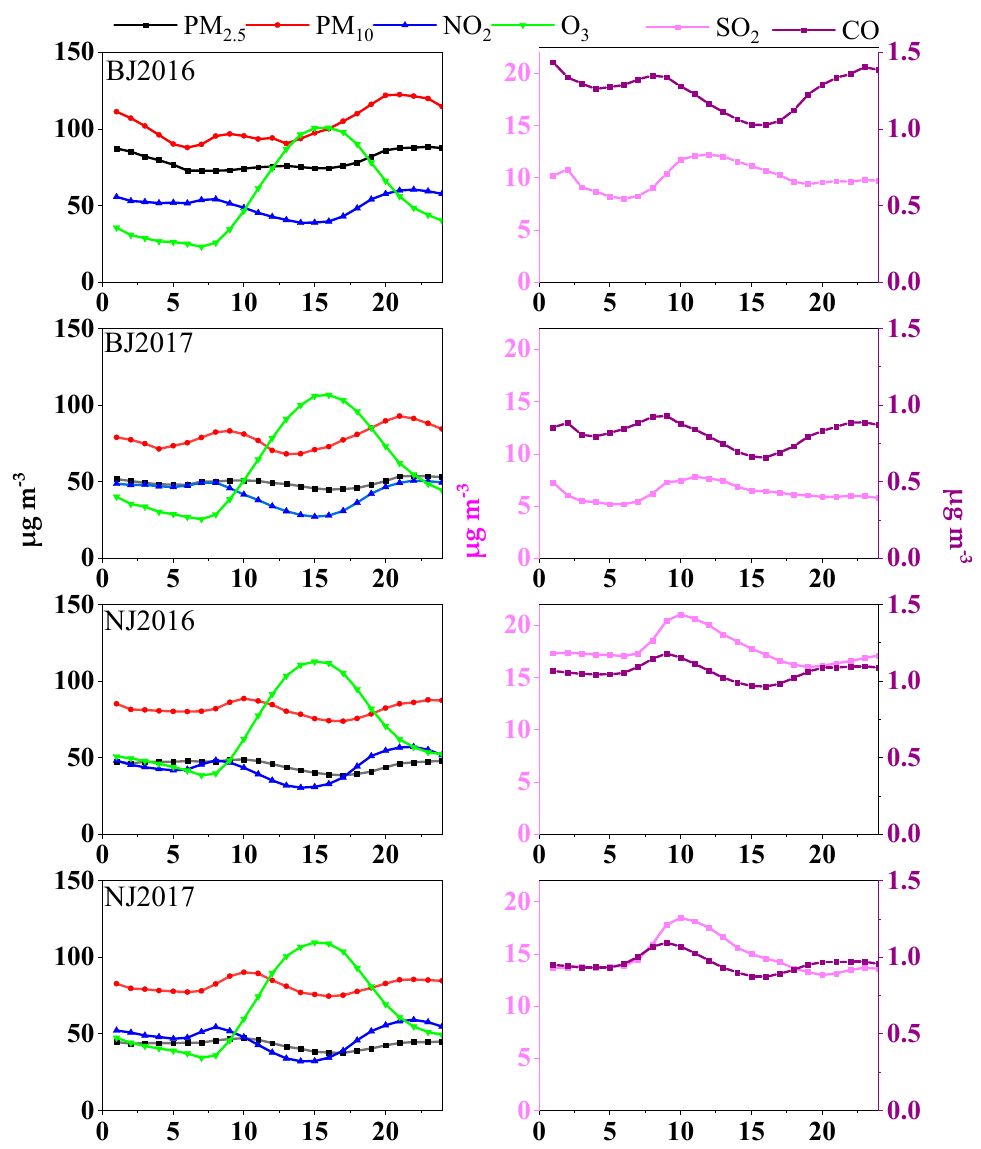
ff erent cities and